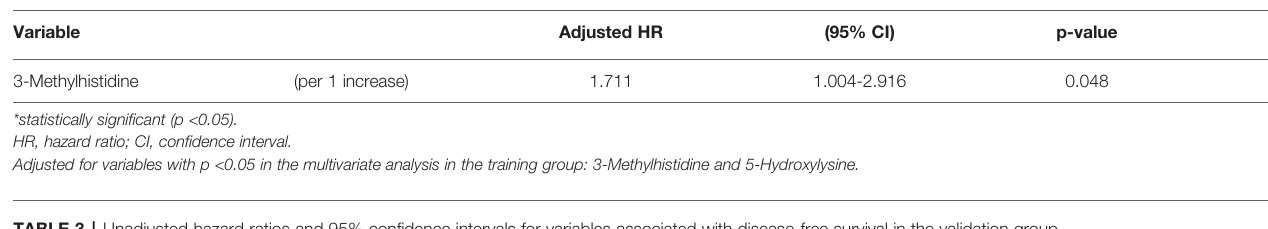
TABLE 3 | Unadjusted hazard ratios and 95% con fi dence intervals for variables associated with disease-free survival in the validation group. Variable Unadjusted HR p-value N-Acetylglucosamine HR, hazard ratio; CI, con fi dence interval. N-Acetylglucosamine was adopted for the fi nal model in this validation set because only N-acetylglucosamine had a p-value <0.05 in the multivariate analysis in the training